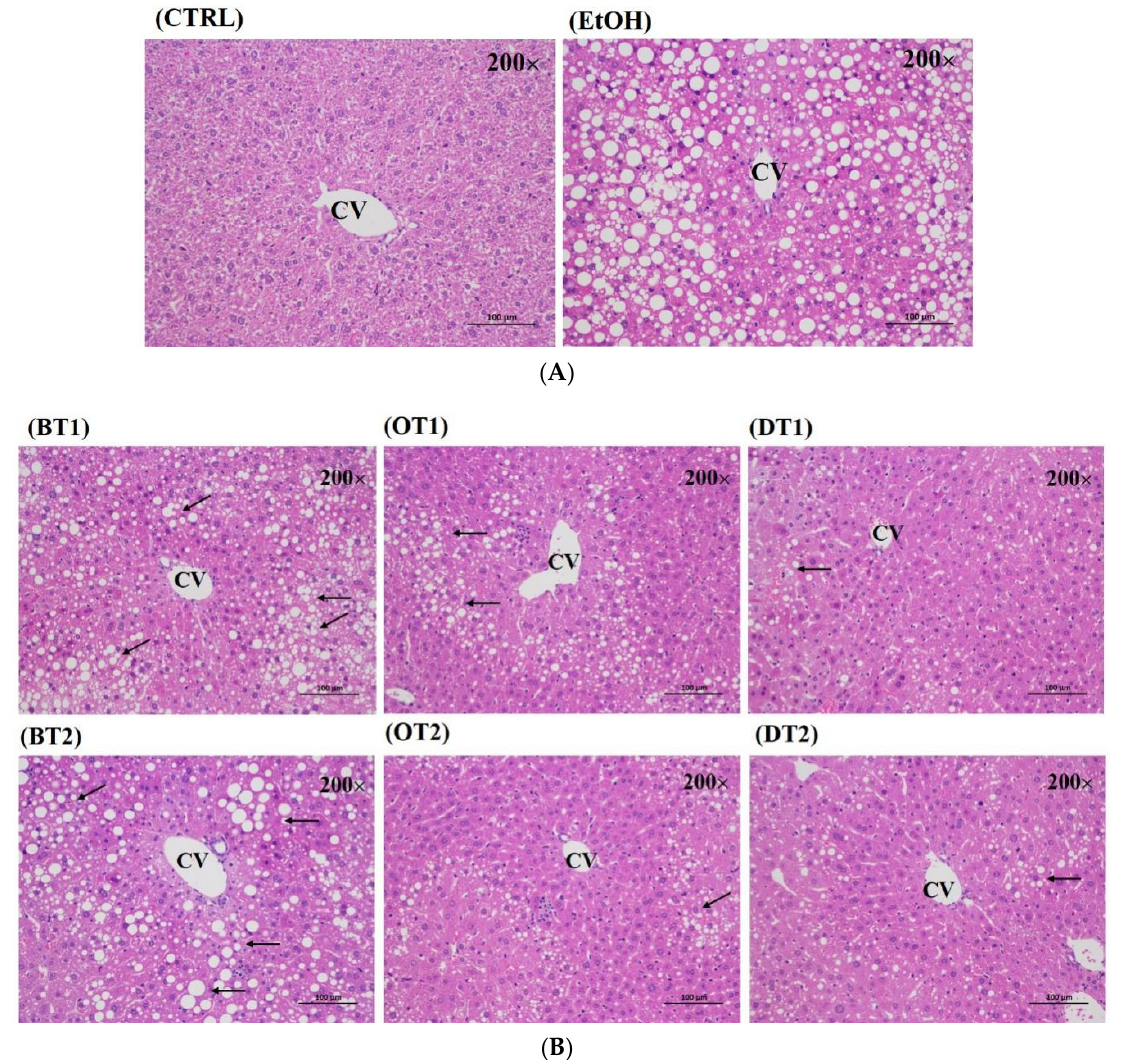
Figure 3. The histopathological examination of hematoxylin and eosin (H&E) stained for all groups (magnification: 200, scale bar: 100 µm). ( A ) CTRL, the control group; EtOH, the model group; ( B ) BT1, Dianhong Tea; BT2, Yingde Black Tea; OT1, Tieguanyin Tea; OT2, Fenghuang Danzong Tea; DT1, Fu Brick Tea; DT2, Selenium-Enriched Dark